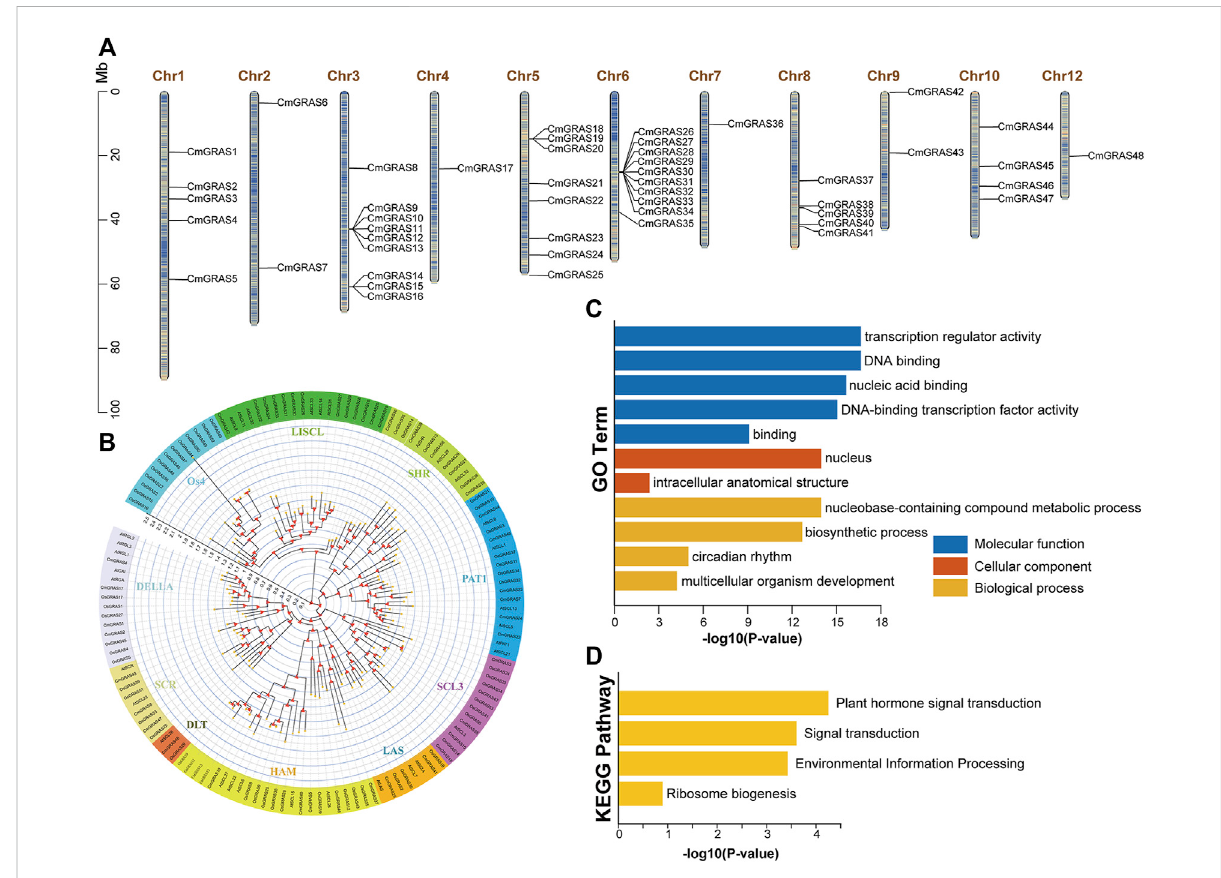
Chromosome distribution, phylogenetic analysis and functional enrichment analysis of CmGRAS genes. (A) Chromosome distribution of CmGRAS genes. The colour of segments in the chromosomes shows the gene density of the corresponding region. (B) The phylogenetic tree of GRAS genes in Chinese chestnut, Arabidopsis thaliana and rice was constructed by maximum likelihood method. (C) GO function enrichment analysis of CmGRAS genes. (D) KEGG function enrichment analysis of CmGRAS